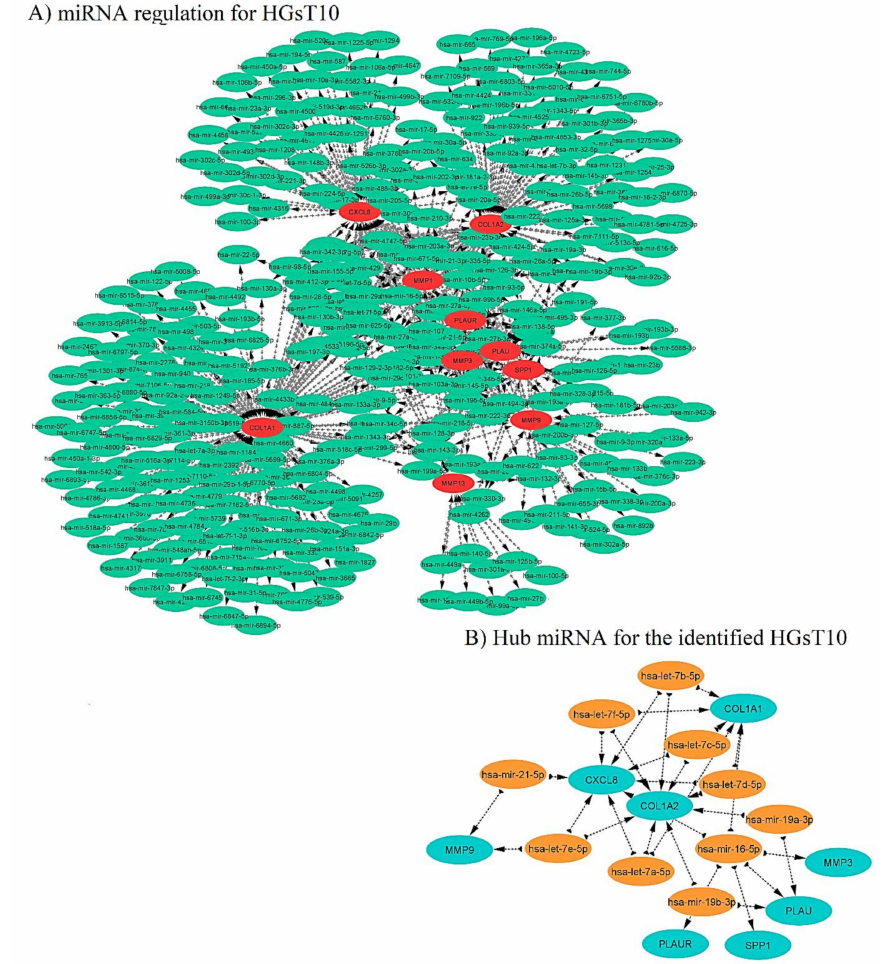
Figure 7. Visualization of the miRNA-gene regulatory network consisted of 377 miRNAs as nodes and 577 edges, including HGsT10 ( A ). The predicted hub miRNA-gene network representation uses the clustering coefficient algorithm consisting of 10 miRNAs as nodes, and 30 edges include HGsT10 ( B